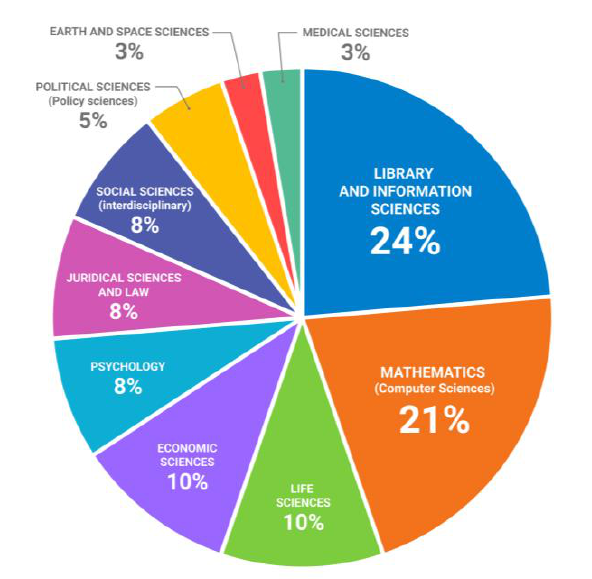
Fig. 4. Fields of OS research (frequency